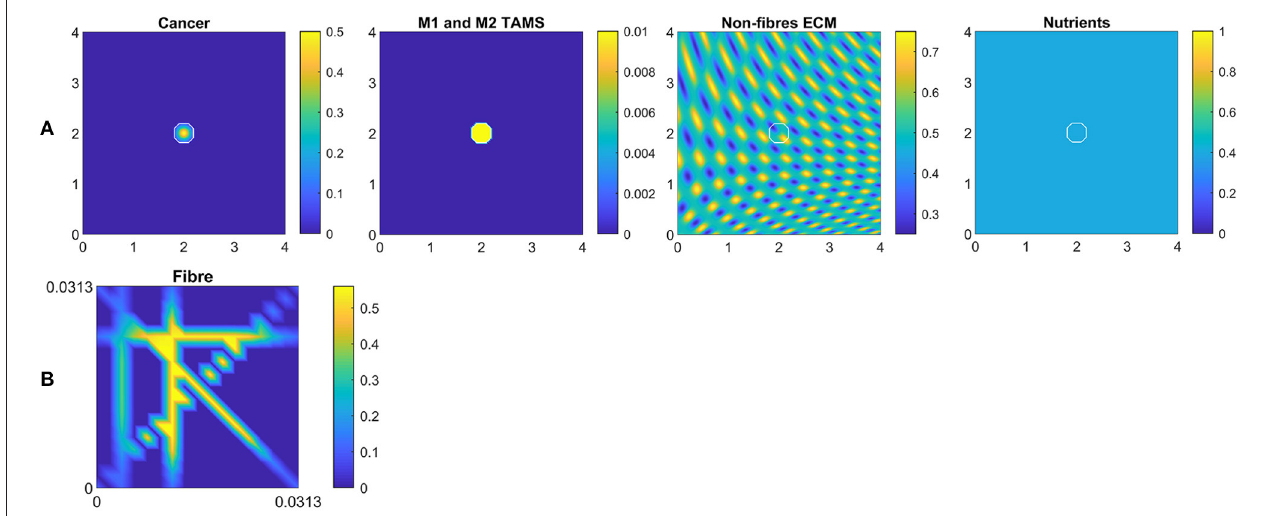
FIGURE 6 | (A) Initial conditions of the cancer cells, both M1 and M2 TAMs, non-fibre ECM and the nutrients, respectively. (B) Initial condition of the micro-fibres on δ Y ( x ), which is repeated for all x .